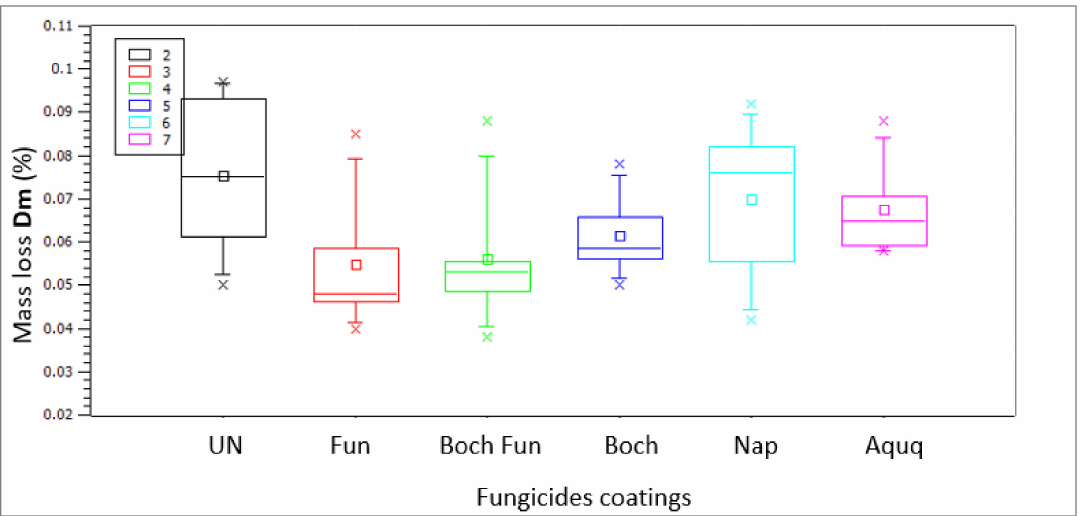
Figure 6. Boxplot of the variance of mass loss for individual fungicide coatings. Legend: UN—untreated with fungicide coating, 2—untreated with fungicide coating, 3—Fun (red), 4—Boch Fun (green), 5—Boch (dark blue), 6—Nap (light blue), 7—Aqua (violet).